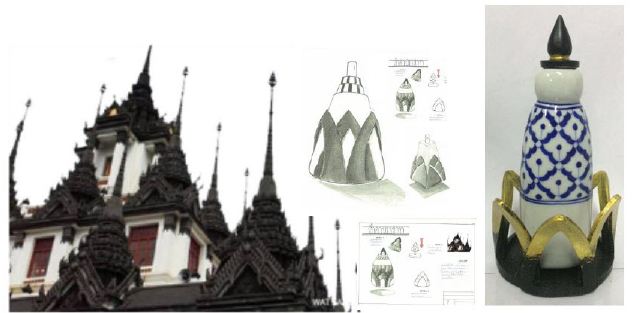
Figure 2. Group 2 design work inspired by Wat Ratchanatdaram (source: created by author) Group 3